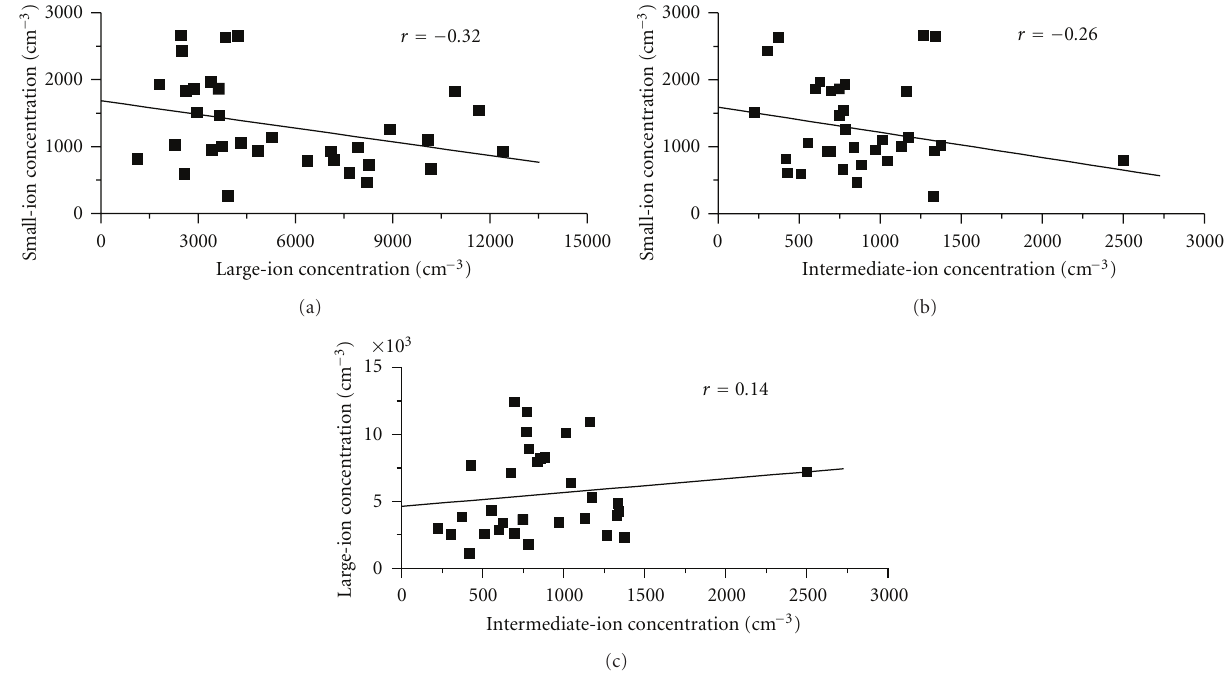
Figure 4: Scattered diagram of daily averaged (a) concentrations of large and small ions; (b) concentrations of intermediate and small ions; (c) concentrations of intermediate and large ions. Line of best fit is also shown.